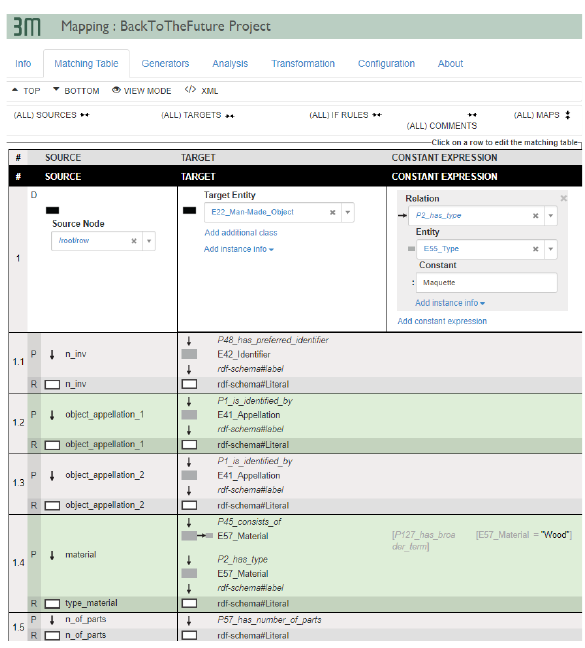
Figure 5. Mapping of data about “maquette” of Nefertari Temple in Abu Simbel ( E22 Man-Made Object ) –